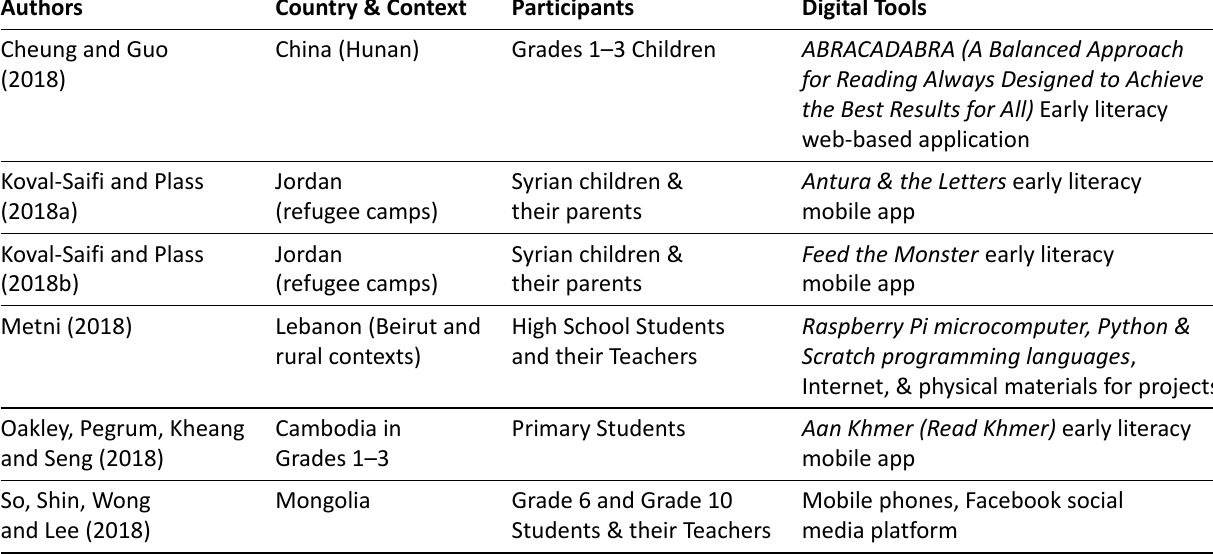
Table 1. Summary of studies retained for